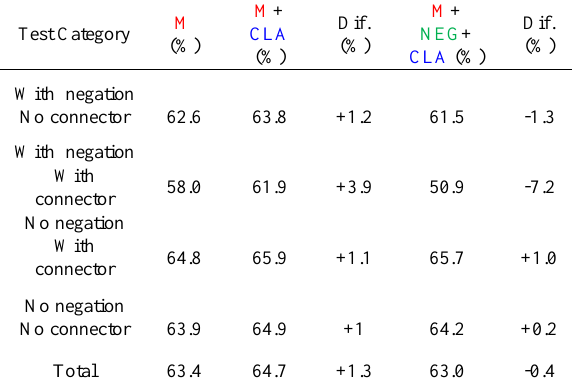
Table 5. Obtained results for local context kernel method with combination of negation and clause related used feature sets in terms of f-measure.